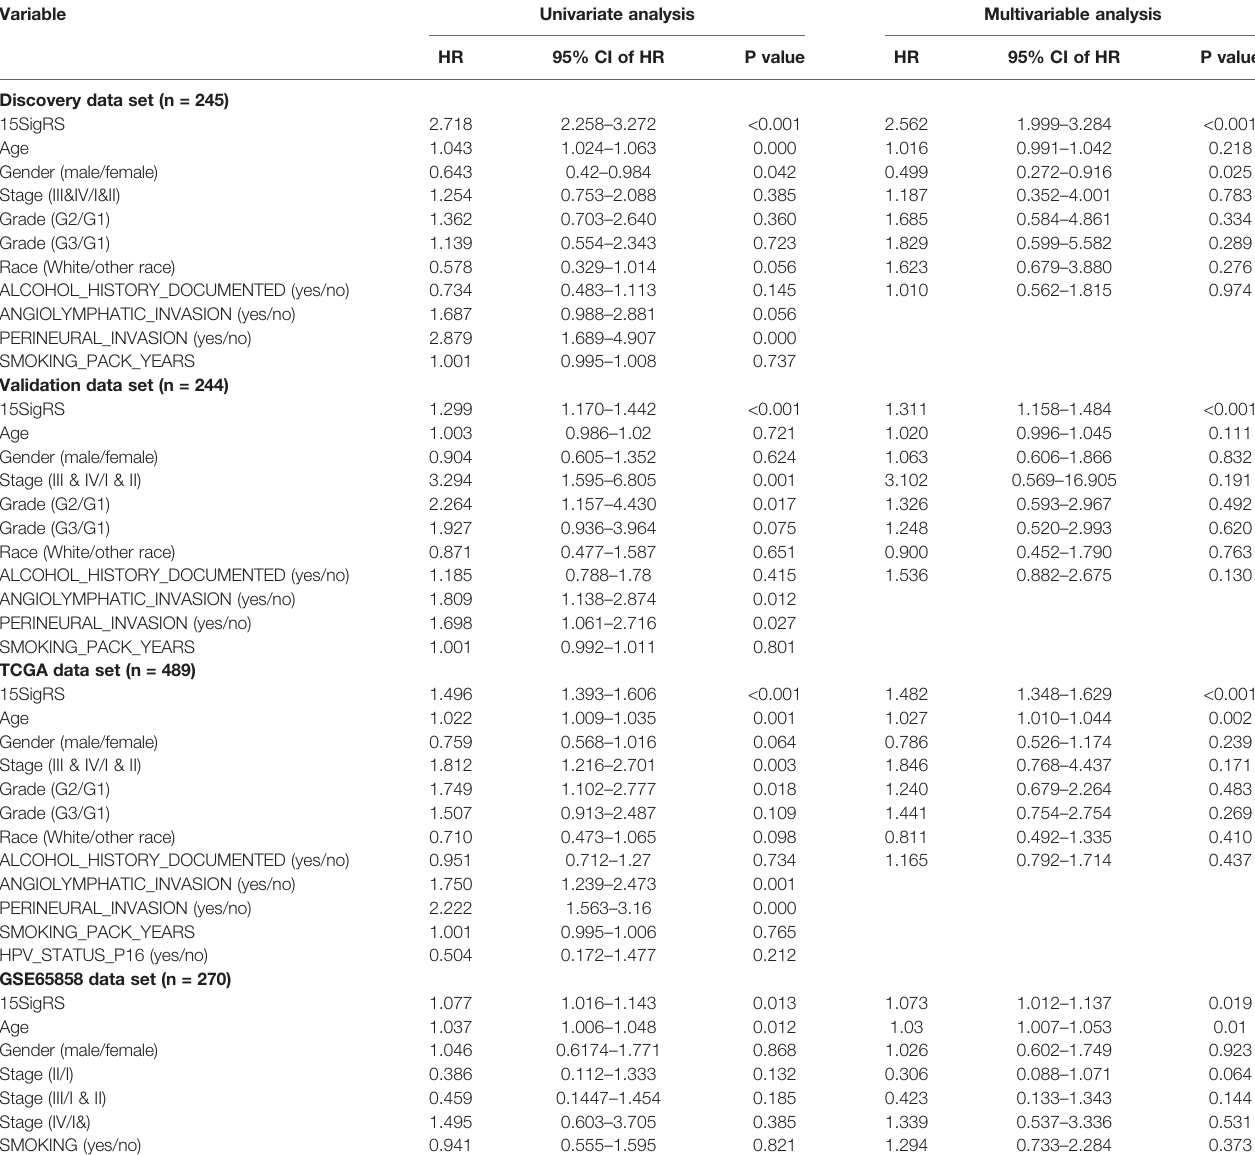
TABLE 2 | Univariate and multivariate Cox regression analysis of OS in each data set.